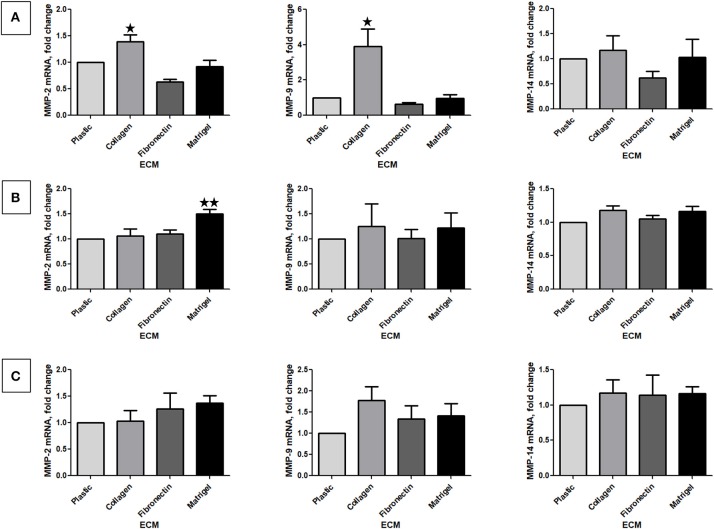
Effect of the different ECM components on MMP-2, 9, and 14 mRNA expression. Relative mRNA levels for MMP-2, 9, and 14 were assessed by RT-qPCR after 24 h of RCC cells cultured on plastic, Col 1, FN1, or Matrigel. (A) Renca cells, N = 3. (B) 786-O cells, N = 4. (C) Caki-2 cells, N = 4. ⋆P < 0.05; ⋆⋆P < 0.01; ⋆⋆⋆P < 0.001.